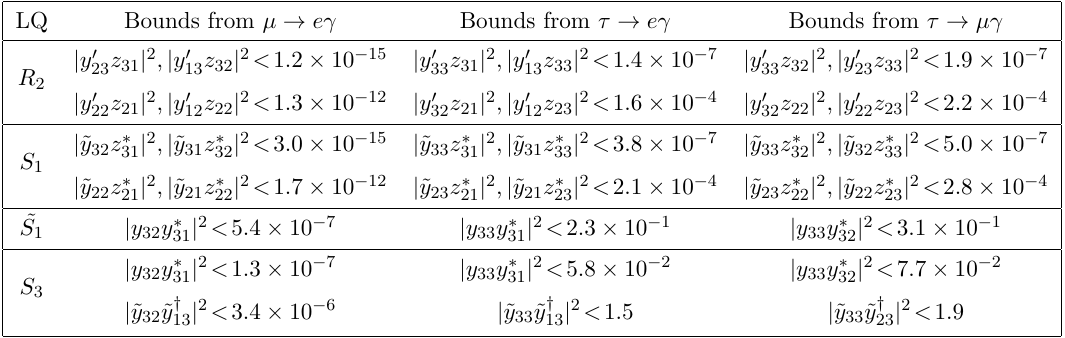
Table 5 . Bounds on leptoquark couplings from ‘ ! ‘ 0 (cid:13) , at 90% C.L. . The limits are obtained for M LQ = 1 TeV, and scale (approximately for R 2 and S 1 ) as M 4